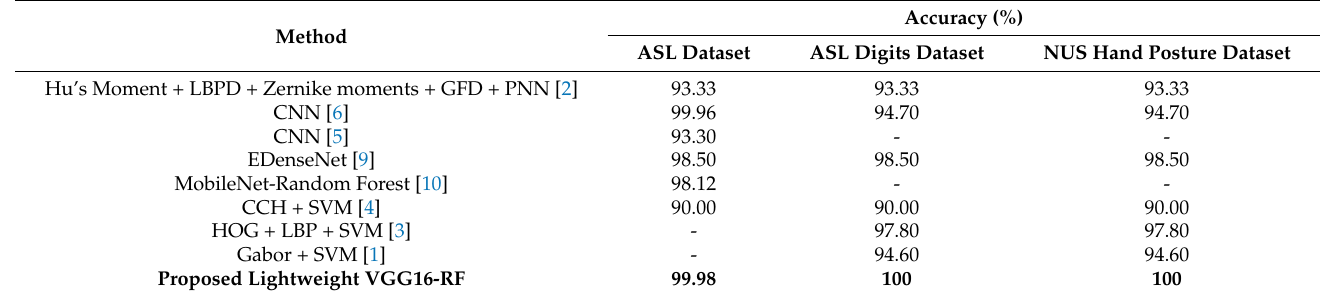
Table 7. Performance comparison among other models and the proposed lightweight VGG16- RF